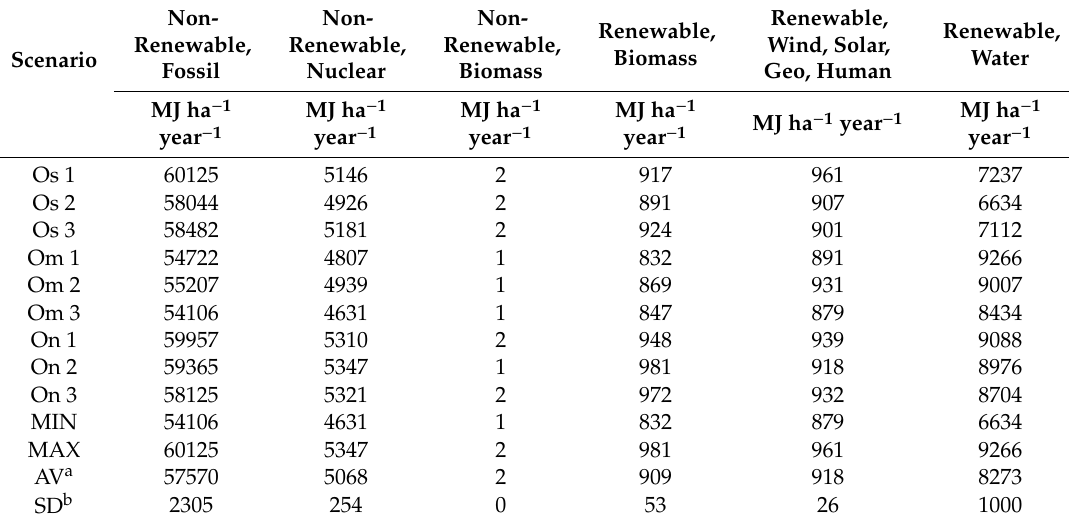
Table 4. Energy results in the integrated farming system .